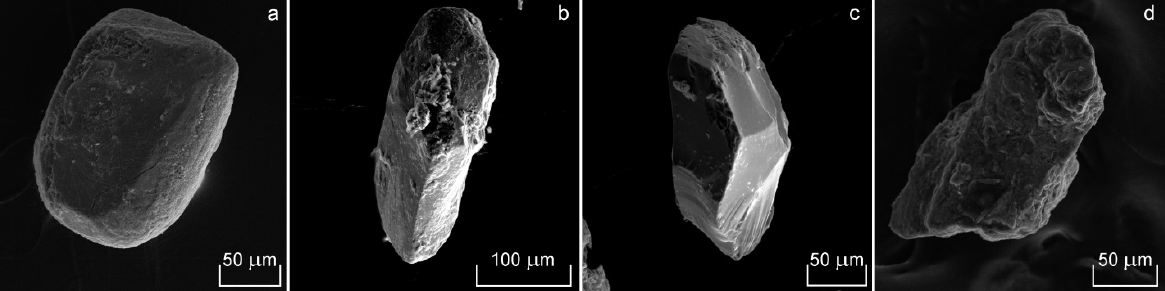
Figure 10. Morphology of chromian spinel grains from the Sukhoy Izyak paleoplacer (SE images): ( a )—flat corroded rhombohedron-like grain (truncated octahedral bipyramidal crystal) (group IV), ( b )—elongated rhombohedron-shaped grain (group IV), ( c )—fragment of crystal (group V), ( d )—xenomorphic corroded grain (group VI).